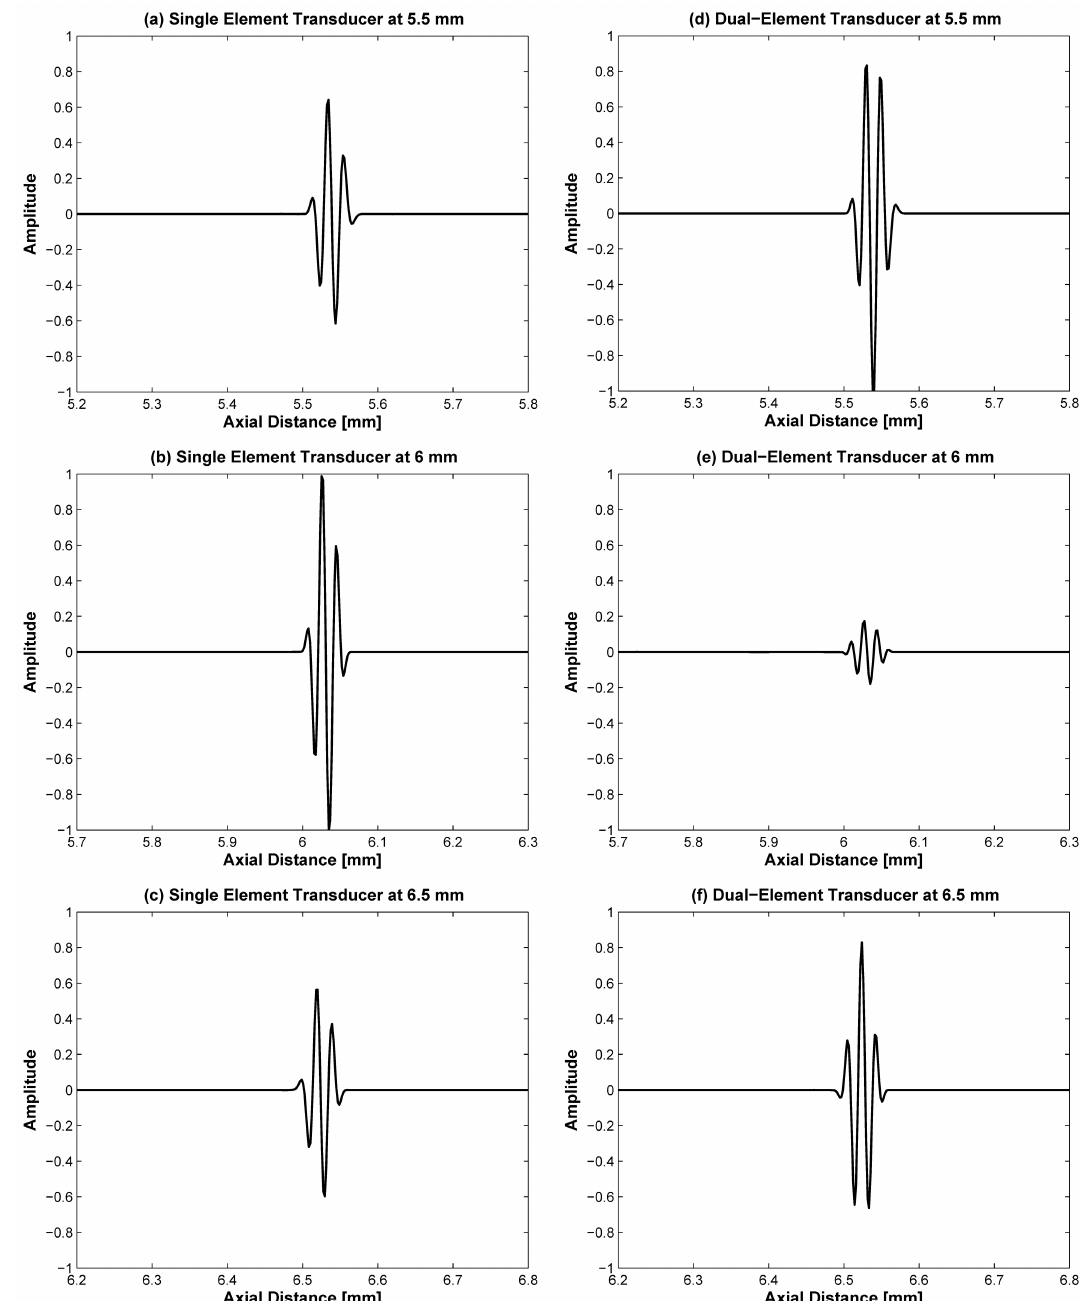
Figure 6. Comparison of the pulse shape between single and dual-element transducers around the focal